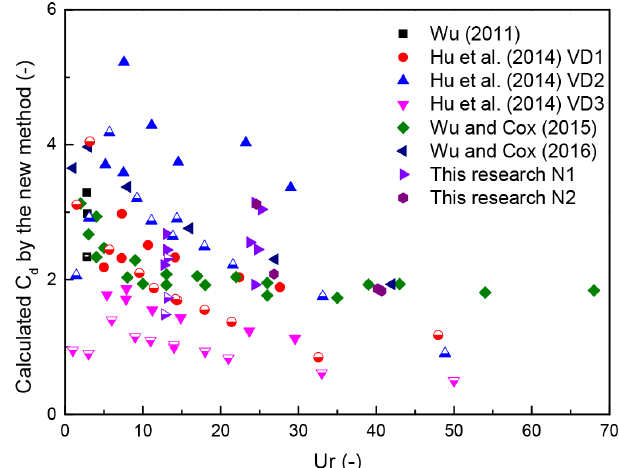
Figure 9. Relation between Ur and the calculated C D by the new method. Details are the same as Fig.